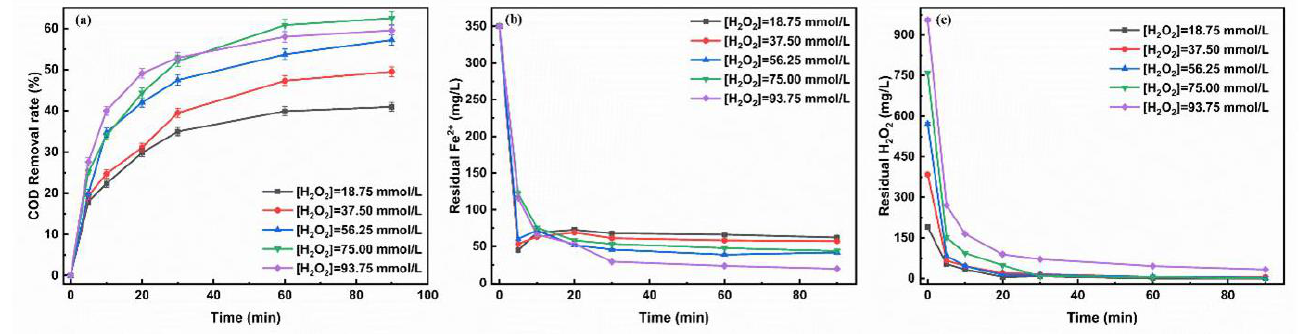
Figure 2. Influence of initial concentration of H 2 O 2 on COD removal rate ( a ), the residual concentra- tion of Fe 2+ ( b ), and the residual concentration of H 2 O 2 ( c ).